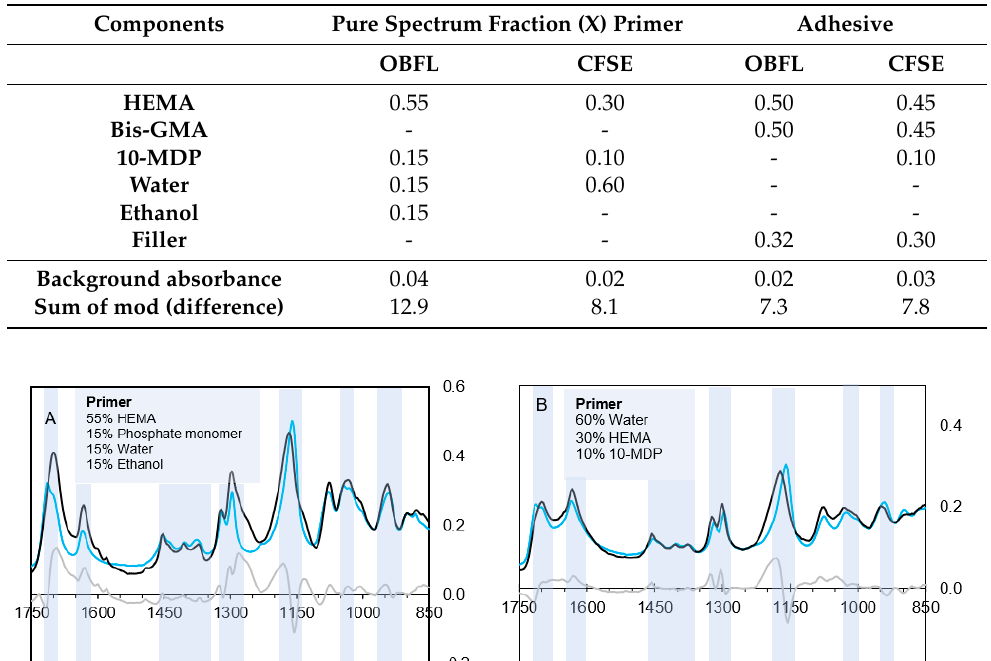
Table 4. Summary table indicating the fractions of different spectra (X in Equation (1)) used to produce the model spectra for OBFL and CFSE. Also provided is the required flat background term and the sum of the modulus of differences that indicates the quality of model fit (Equation (4)).